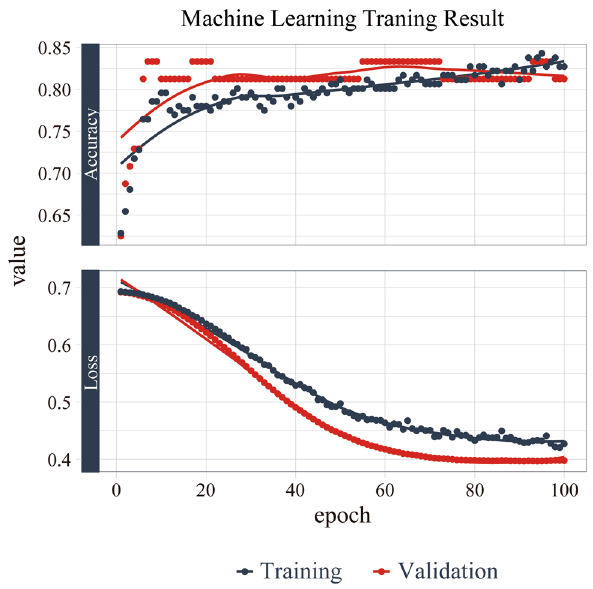
Figure 1. Training and validation curves. The training progress is shown by plotting the loss of each iteration. The accuracy of the validation set is also plotted together for every epoch.